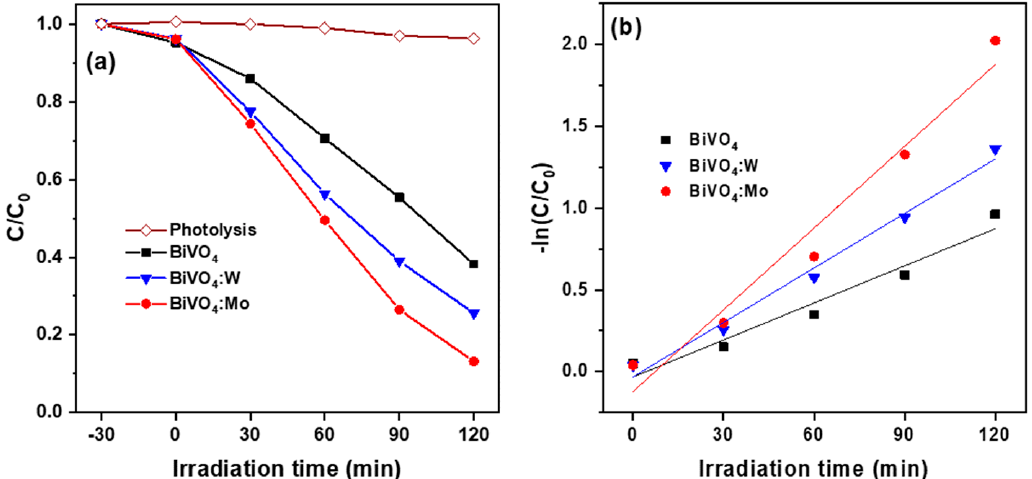
Figure 9. ( a ) Photocatalytic activity and ( b ) the first-order kinetics for degradation of diluted RhB solution by BiVO 4 -based nanoparticles under visible light irradiation.